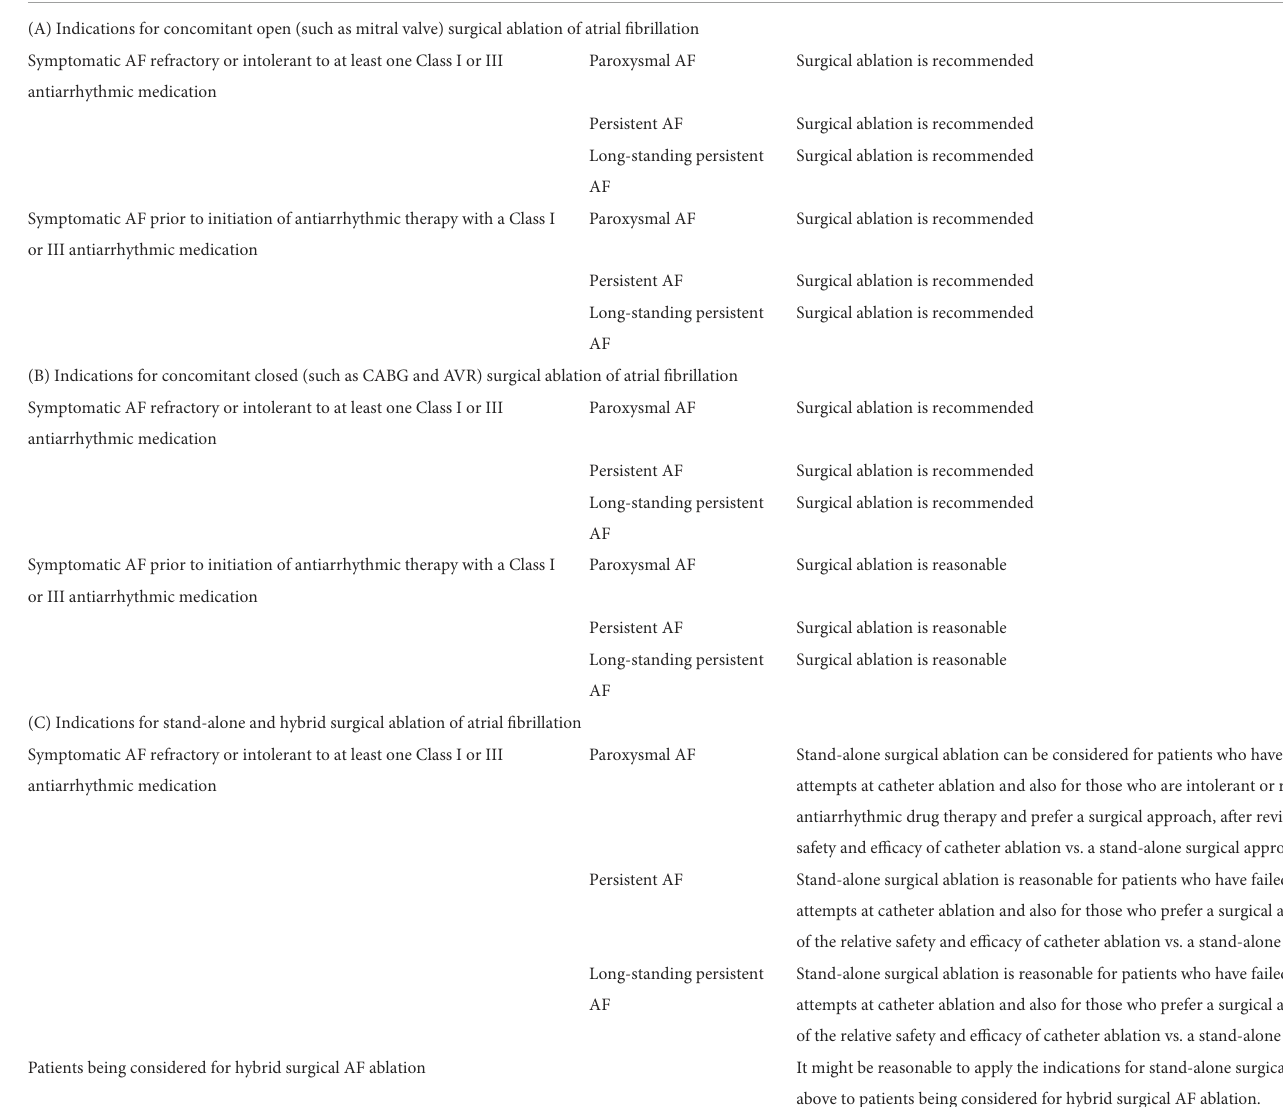
TABLE 1 Indications for surgical ablation of atrial